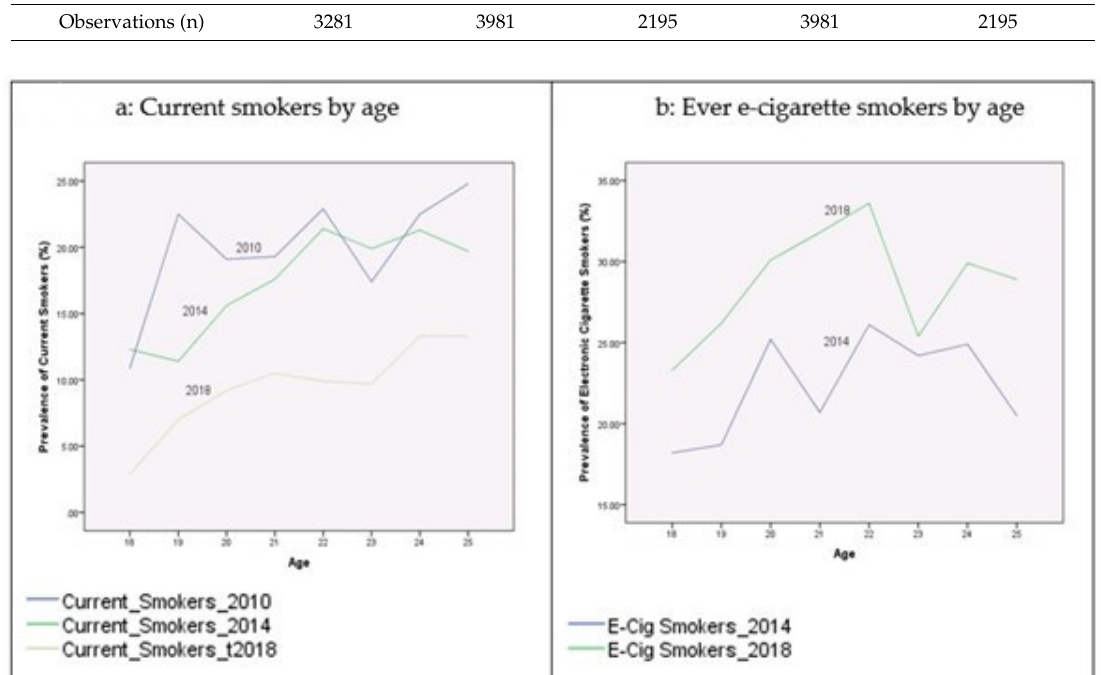
Figure 2. Prevalence of smoking behaviors by race/ethnicity, NHIS 2010–2018.